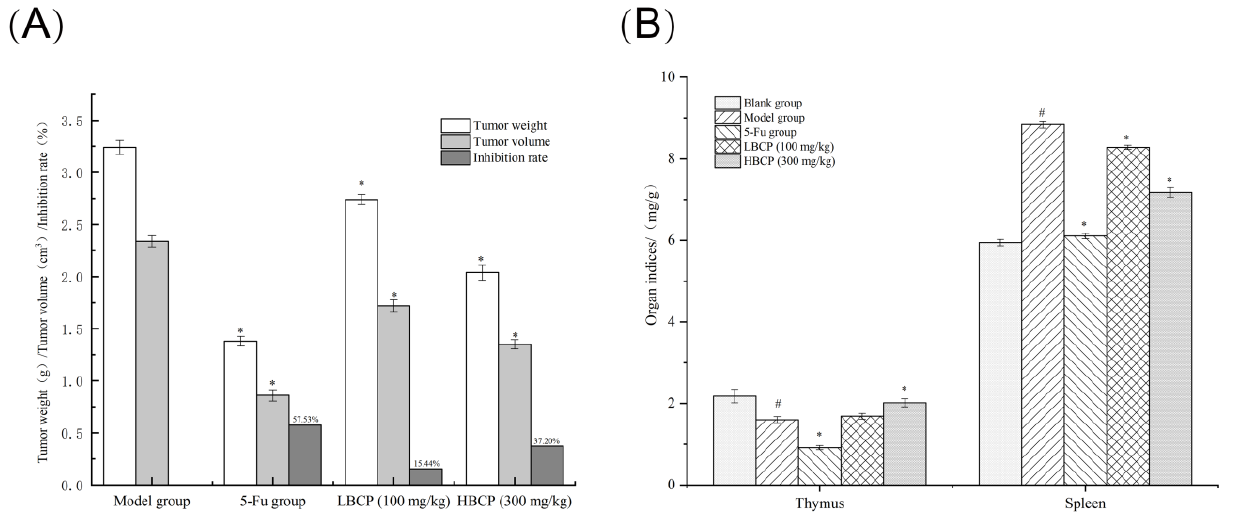
Figure 11. ( A ) Tumor weight and tumor volume of H22 tumor-bearing mice; ( B ) Immune organ indices (Thymus and spleen) of H22 tumor-bearing mice. # p < 0.05 indicated significant compared to blank group; * p < 0.05 indicated significant compared to model group.